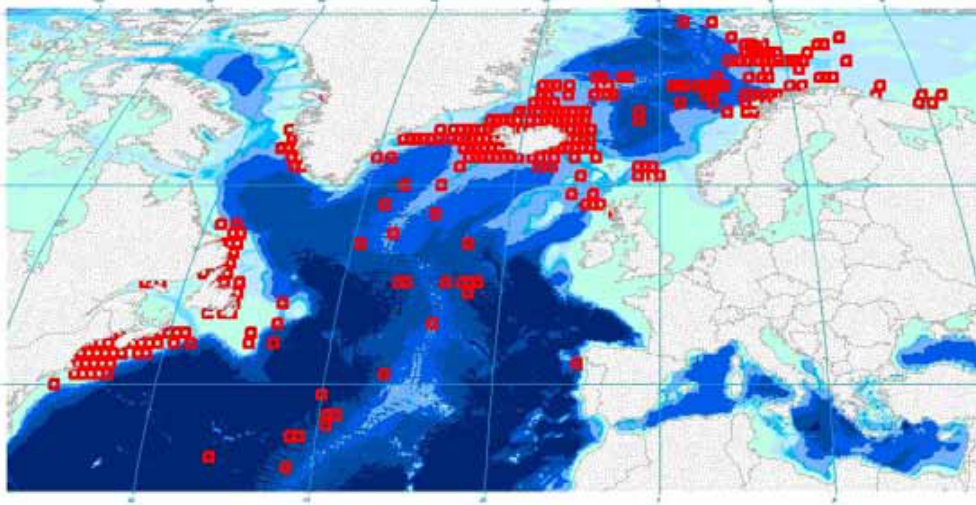
Figure 1. The location of those 1 degree squares of latitude and longitude where humpback whales were reported during July and August in 1 or more sets of sightings data collected aboard whaling, research and whale watching vessels. Whalers included mid 20 th century baleen whalers (Sigurjønsson and Gunnlaugsson 1990) and mid 19th century sperm whalers (Reeves et al. 2004). Research vessels included late 20 th and early 21 st century fishery surveys and directed cetacean sighting surveys (Paxton et al. 2009, Pike et al. 2009). Whale watching vessel data was primarily from the Gulf of Maine (Peter Stevick personal communication). Search effort and efficiency varied greatly among the data sets, so only presence and absence are shown in order to describe broad scale spatial distribution